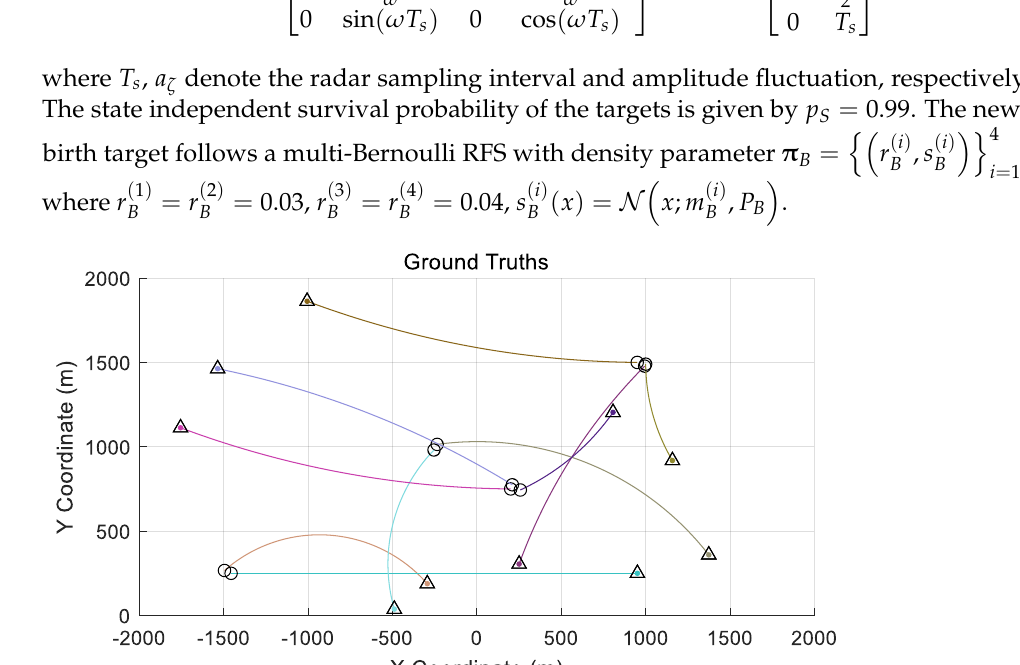
Figure 4. Multiple-target trajectories in the x − y plane. Start/Stop positions for each track are shown with ○ / △ . And different colored lines represent different trajectories.